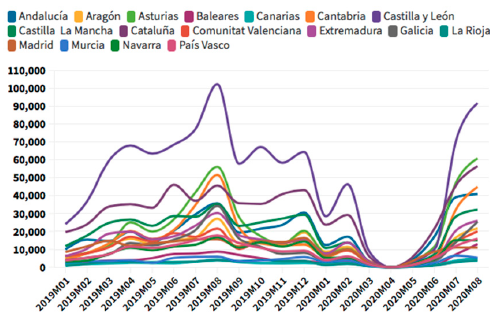
Figure 11. Domestic tourism rural occupancy. Source: Self-made from INE data.